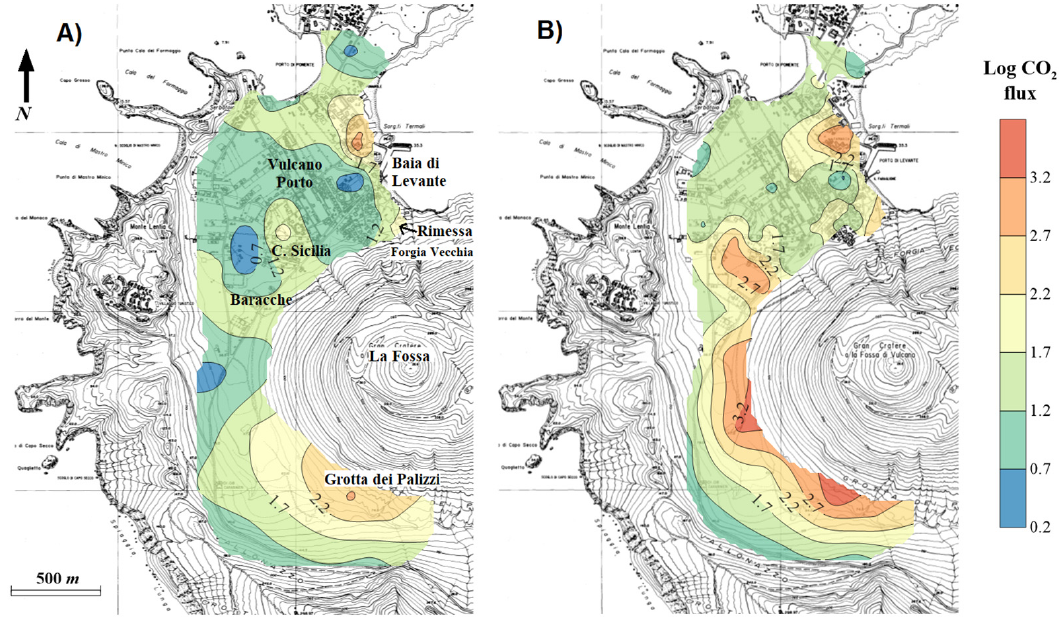
Figure 10. ( A ) Spatial distribution of the soil CO 2 flux during a normal degassing state (September 2021); ( B ) spatial distribution of the soil CO 2 flux during the crisis (November 2021). The base map is extracted from the Carta Tecnica Regionale (1:10,000, EPSG: 25833, www.sitr.regione.sicilia.it, (accessed on 29 December 2022)); the maps of CO 2 flux were obtained by using the Kriging algorithm of the Surfer package v. 10 (Golden Software).